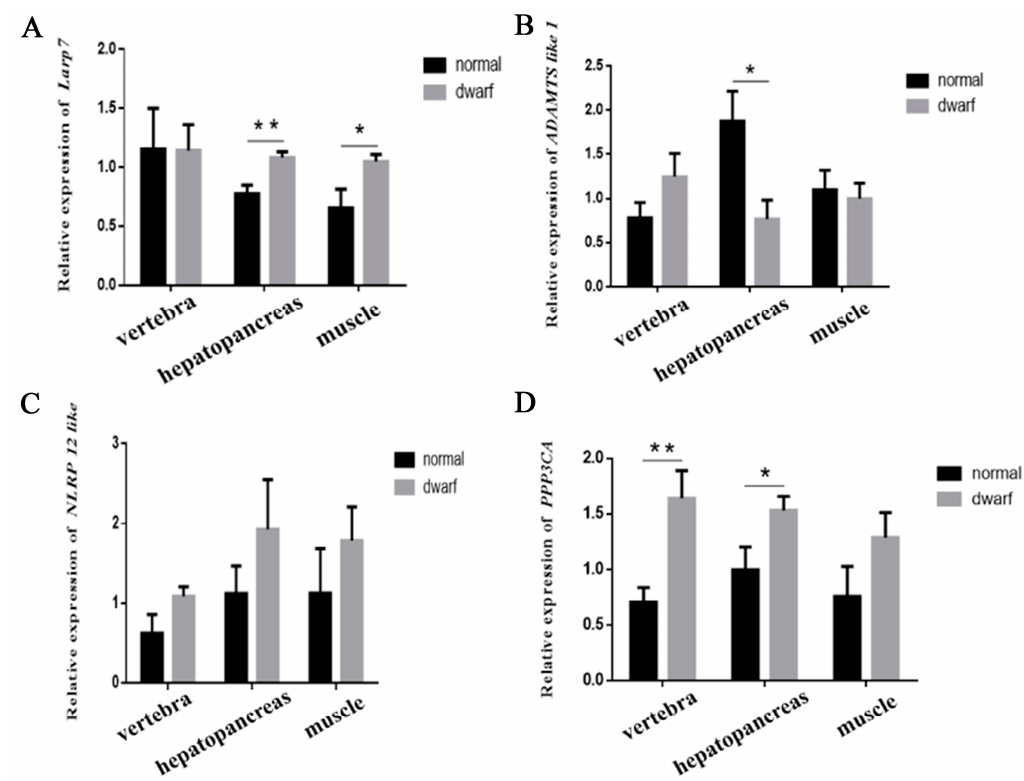
Figure 5. Comparison of the relative expression levels of genes in the candidate region in di ff erent tissues of the white normal sailfin molly (black bars) and the white dwarf sailfin molly (gray bars). ( A ) Relative expression level of Larp7 ; ( B ) relative expression level of ADAMTS like 1 ; ( C ) relative expression level of NLRP 12-like ; ( D ) relative expression level of PPP3CA . Each bar represents the mean ± SE for each molly group (n = 8 for each group). * The values of gene expression levels are significantly di ff erent from each other ( p < 0.05). ** The values of gene expression levels are significantly di ff erent from each other ( p < 0.01).